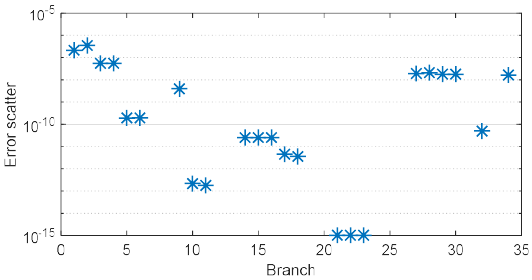
Figure 10. Error scatter of each branch.